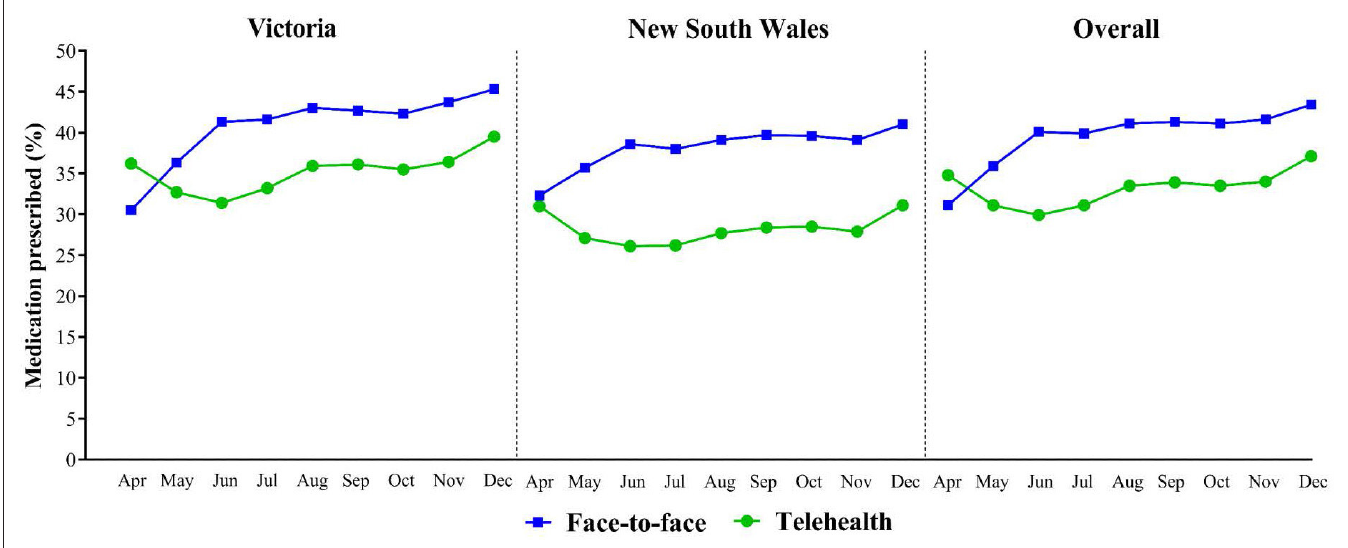
Figure 2 Risk- adjusted rate of prescribing at least one medication by month of GP consultation, April–December 2020. Risk- adjustment included patient level variables (age, sex, socioeconomic status, patient status, and the remoteness